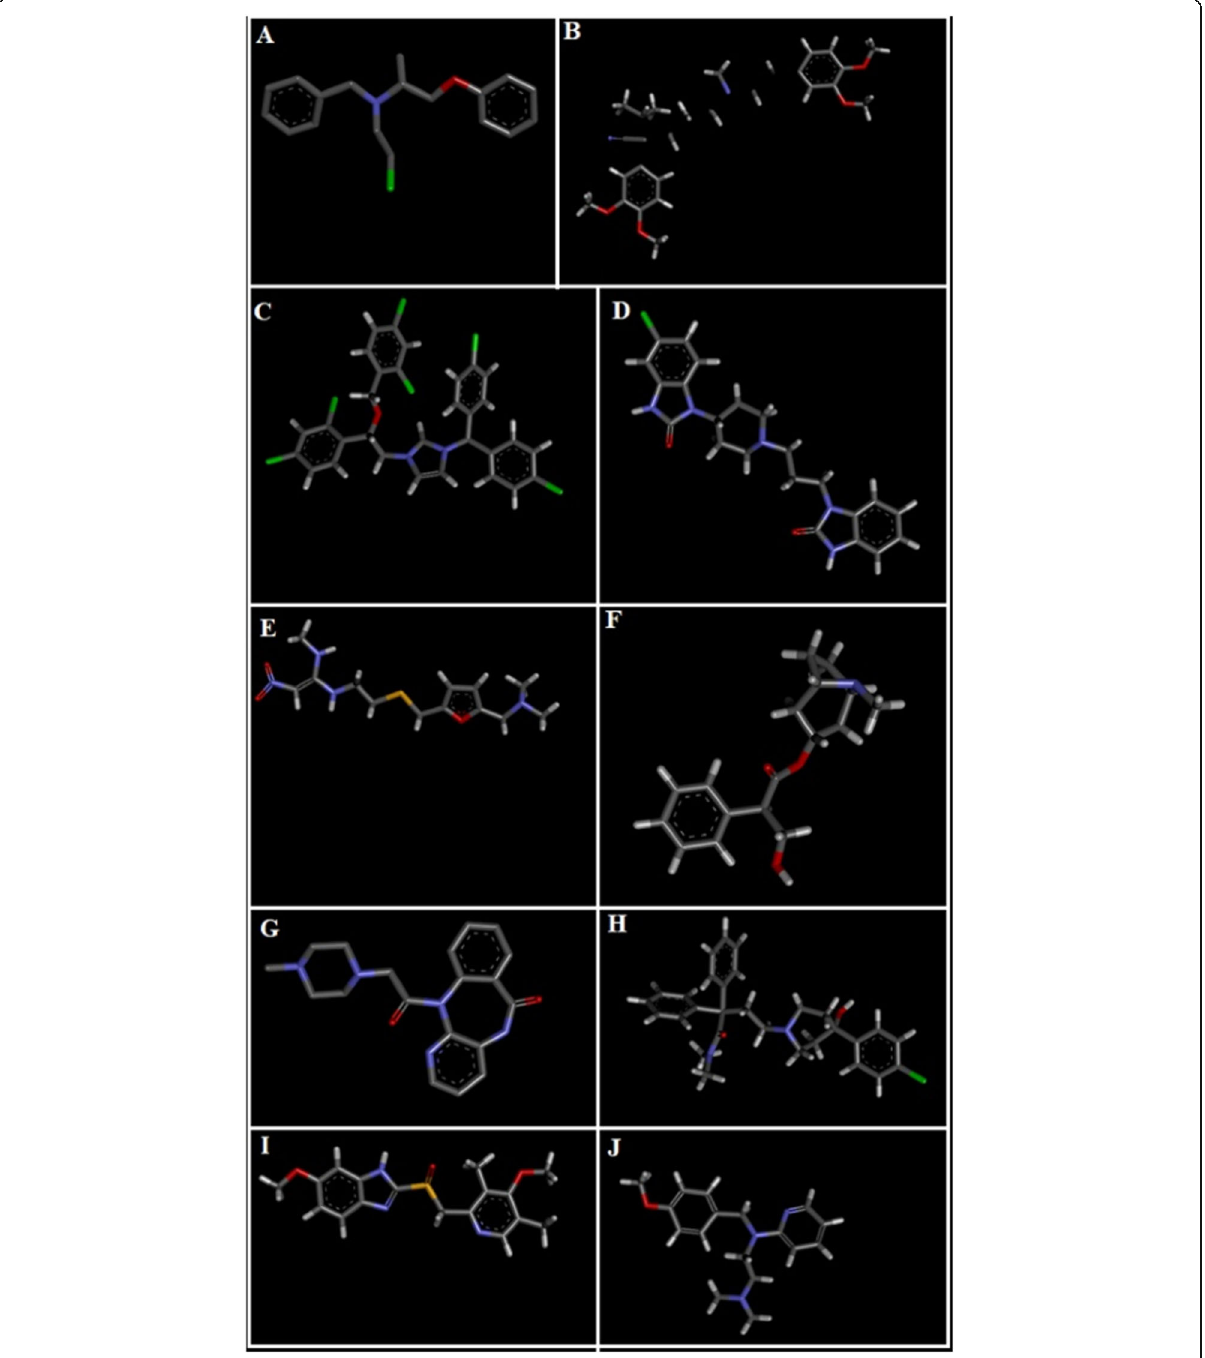
Fig. 1 3D-structures of reference drugs: a phenoxy benzamine, b verapamil, c calmozolium, d domperidone, e ranitidine, f piranzapine, g atropine, h loperamide, i omeprazole and ( j ) pyrilimine, drawn through Chem Sketch 2015, 2.5 and saved in PDB format through Biovia Discovery Studio 2016. Atoms are shown by colors; gray color (carbon atoms), white color (hydrogen atoms), red color (oxygen atoms), blue color (nitrogen atoms), dark red (bromine), and yellow color (sulfur